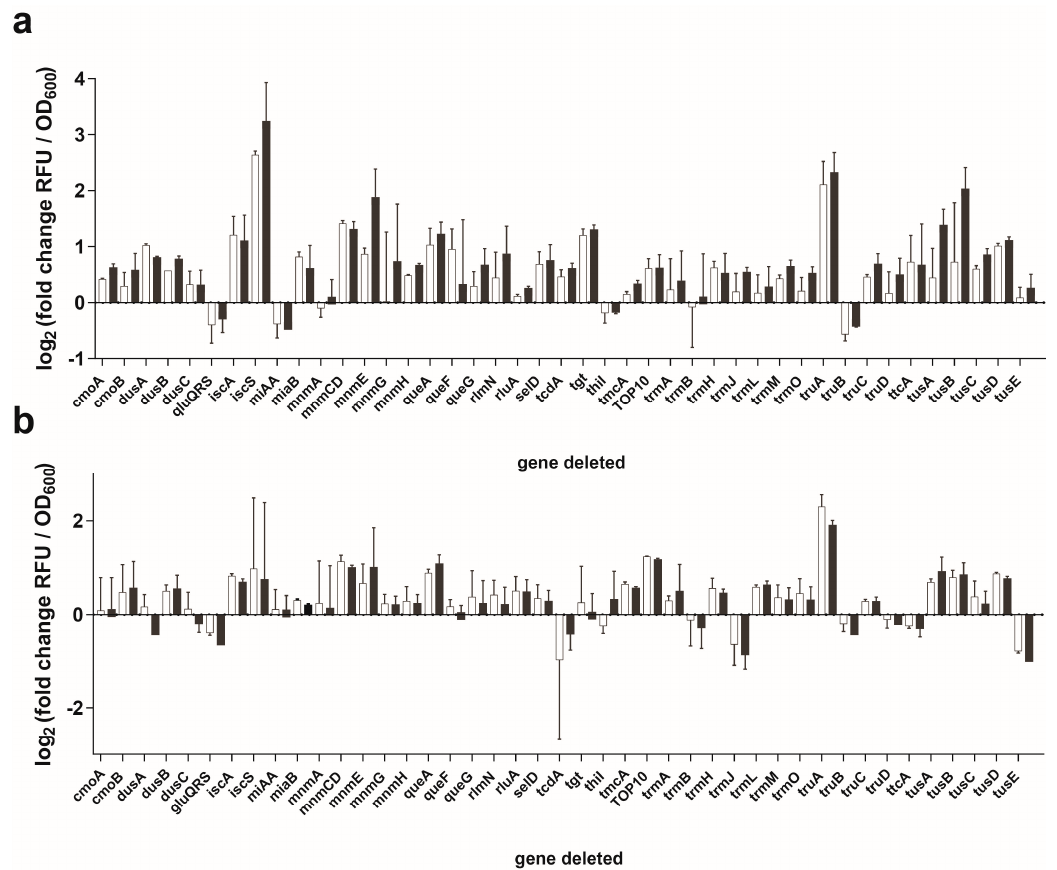
Figure 3. Stop codon read-through assays with sfGFP-2TAG in 42 selected Keio collection strains with full Sep-OTS ( a ) and with suppressor tRNA SepCUAG37A only ( b ). First column (white) corresponds to the signal recorded in the media without, and the second (black) with 5 mM Sep. Fold change values were derived from 4–8 ( a ) and 3–6 biological replicates ( b ).